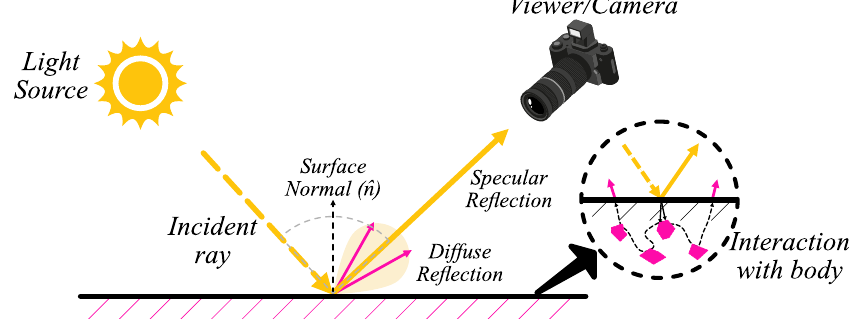
Figure 1. The dichromatic reflection model for inhomogeneous